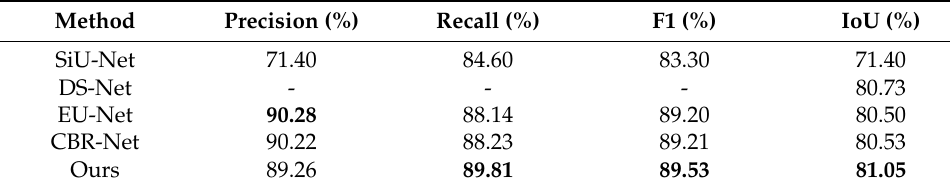
Table 7. Quantitative comparison of MEC-Net using the Inria